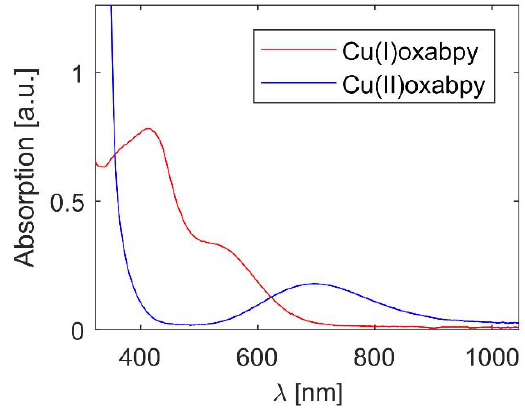
Figure 2. Absorption spectra (solid lines) of Cu I (oxabpy) (red) and Cu II (oxabpy) (blue). Table 1. Optical and Electrochemical Characteristics of Cu I/II (oxabpy) Complexes.